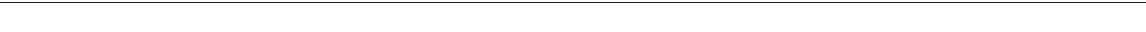
Fig. 3 Using distance-based measures and entropy as indicators of clonal outgrowth of lymphoma. a Dynamic Time Warping was used to cluster clonality pro fi les of all samples and identi fi es two major groups; early-stage samples (blue) and samples undergoing clonal outgrowth (red). Near identical clusters were obtained using the Kolgomorov – Smirnov statistic (Supplementary Data 1). b Samples are plotted comparing entropy score by rank and individual samples are colored by cluster branch, indicating both entropy scores and clustering give a similar bifurcation of samples. c Distribution of entropy scores between the two clusters indicates an entropy value of 3.5 effectively separates the groups. The mean (horizontal line), ±1 s.d. (box), and ±2 s.d. (vertical line) are indicated. d Distribution of entropy scores between different time points indicates a progressive increase in the frequency of clonal outgrowth (mean (horizontal line), ±1 s.d. (box), and ±2 s.d. (vertical line)). Superimposing the clonality pro fi les of all samples within each cluster indicates consistent shape within the low entropy group ( e ) and within the high entropy group ( f ). A normalized clonality value of 0.1 is used to differentiate clonal